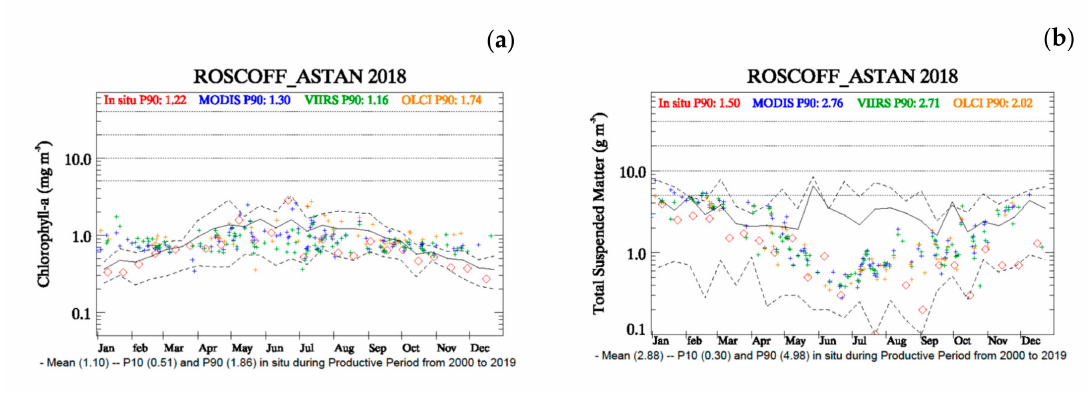
Figure 7. Chl-a ( a ) and TSM ( b ) at Rosco ff Astan in 2018. In situ and satellite percentiles of year 2018 are indicated in the upper part of the graphs; the in situ historical mean, P10 and P90, calculated over the productive period, are indicated under the time